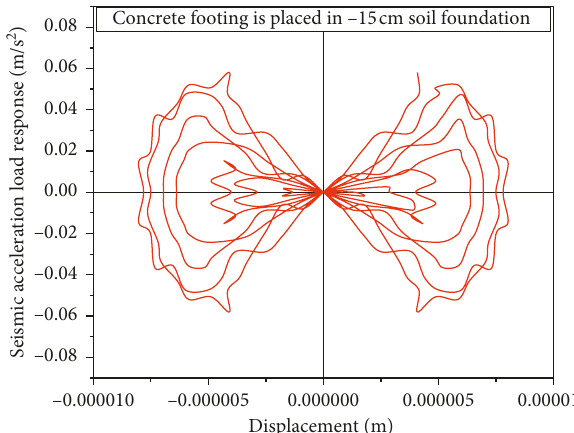
Figure 6: Seismic acceleration load response vs displacement at the base of a concrete footing, during concrete footing-soil foundation interaction.